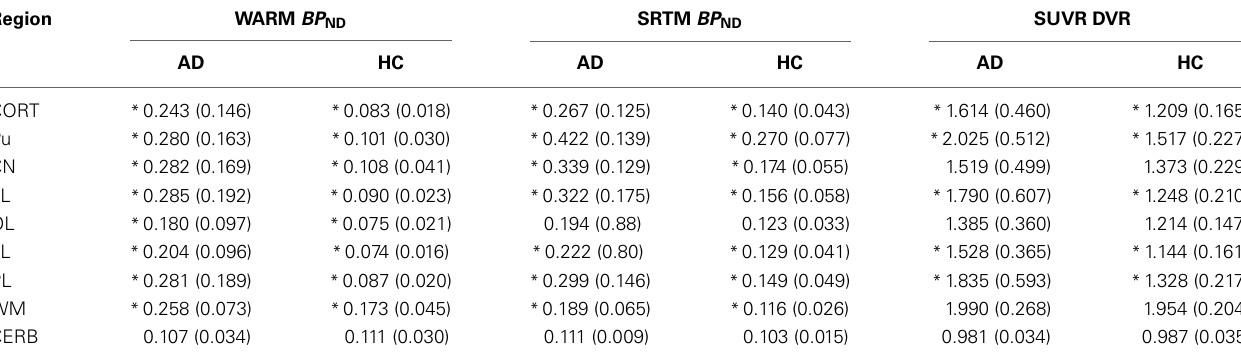
Table 2 | BP ND and DVR values measured for AD vs. HC subjects using three different methods ( ∗ indicates statistical significance between subject groups p < 0 .